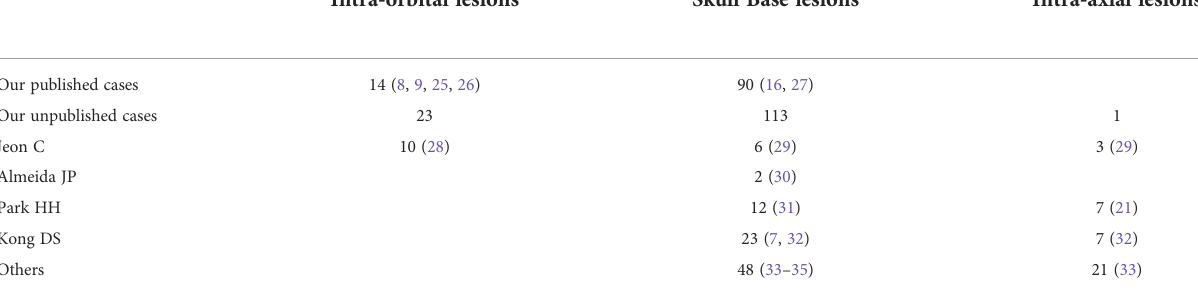
TABLE 2 Personal published and unpublished data and other groups'experiences with